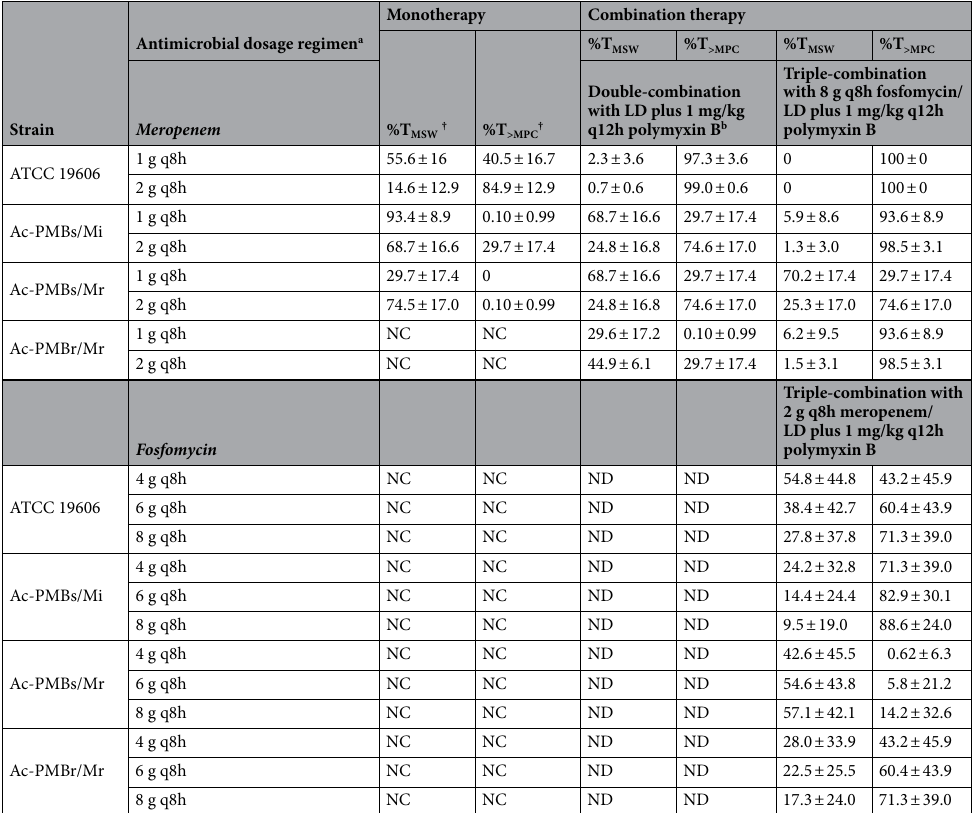
Table 3. MSW-derived PD indices of meropenem and fosfomycin as monotherapy and in combination against A. baumannii strains. MSW mutant selection window, MPC mutant prevention concentration, LD loading dose of 3.0 mg/kg, NC not computable because polymyxin B MIC is higher than maximum. ND not tested. Values reported as mean ± SD. a Meropenem and fosfomycin regimens were administered as 3-h prolonged infusions. b Polymyxin B regimen were 1-h infusions. c T MSW or T >MPC was calculated as the percentage of the first 24